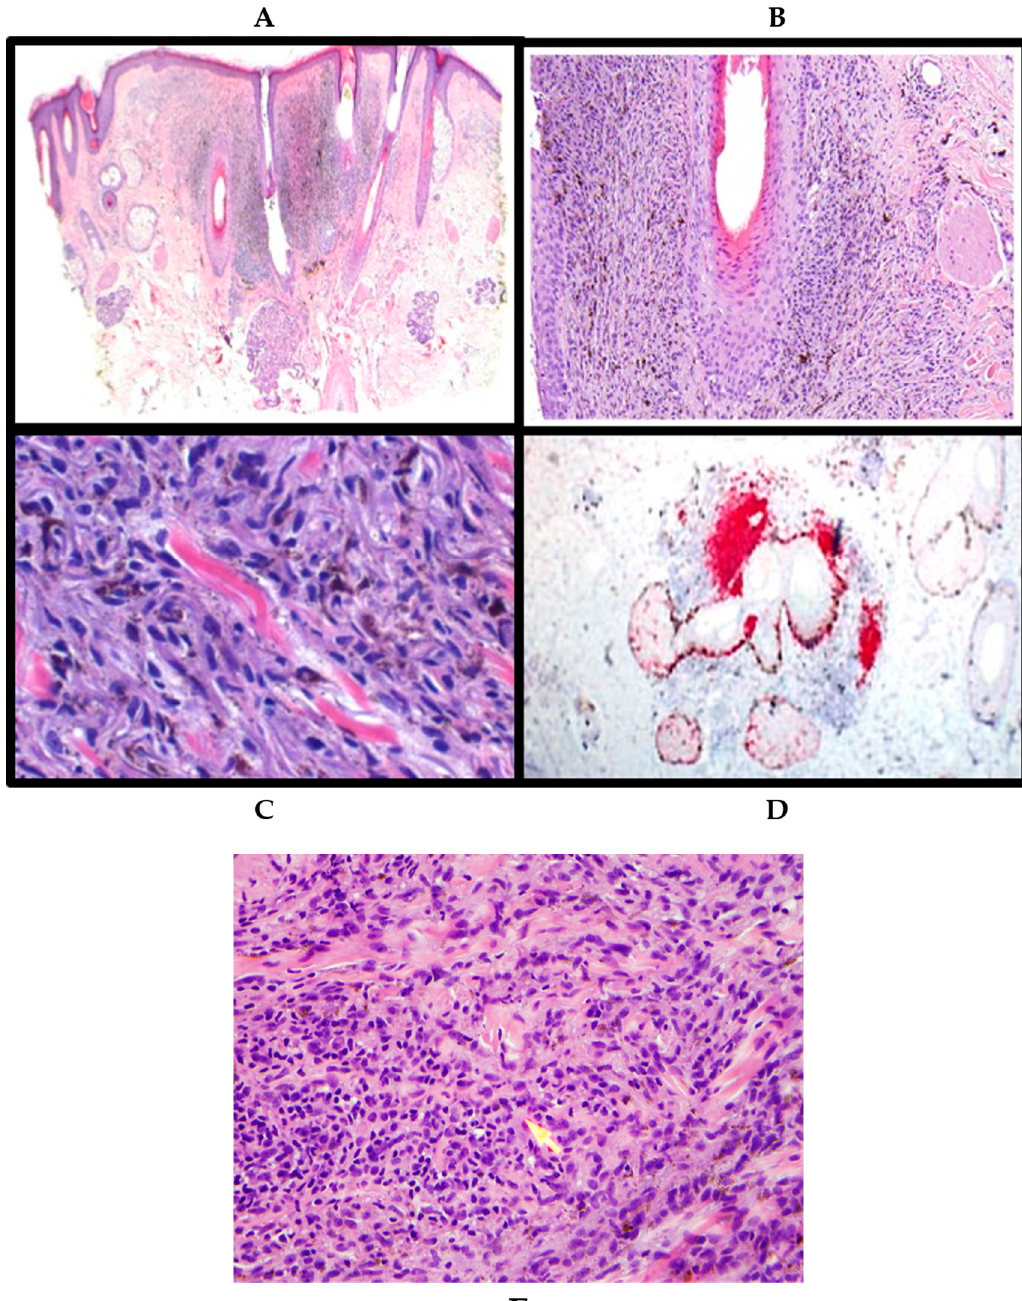
Figure 1. Punch biopsy revealed a tumor located predominantly in the dermis ( A ); The tumor cells were composed of spindled, dendritic, and epithelioid melanocytes containing variable amounts of melanin pigment, with some melanocytes being very heavily pigmented, mcrospoic magnification (mm): ×4 ( B ); Multiple level sections demonstrated that the tumor cells were growing in sheets originating in continuation with nests in the hair follicle, mm: ×10 ( C ); The tumor cells involved the follicular structures in nests or groups of atypical melanocytes growing in the outer root sheath of hair follicles, involving sebaceous glands, with predominant accumulation in the bulge area (red stain as identified by antibodies against MART-1 and SOX-10 antigens), mm: ×20 ( D ); Mitotic figures were identified (arrow), mm: ×10 ( E ).